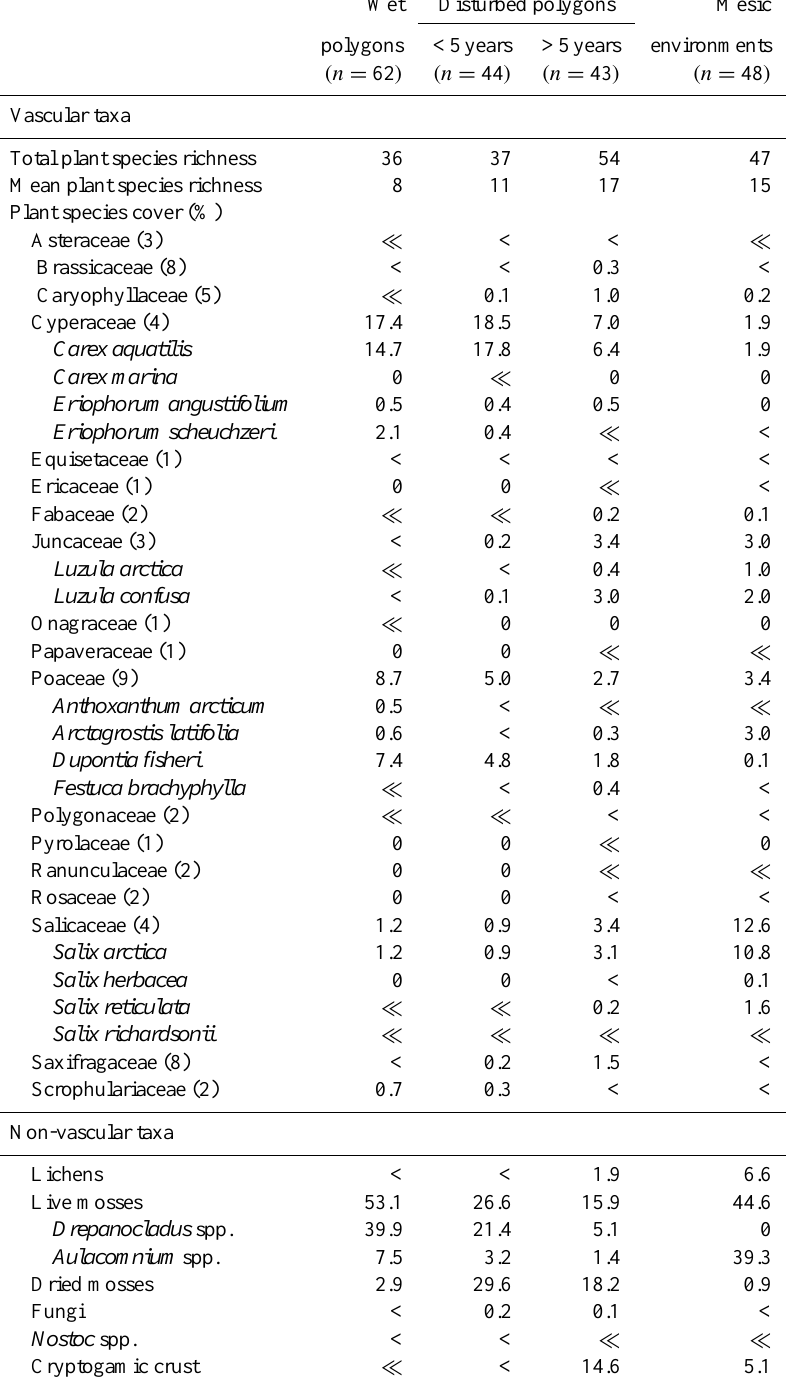
Table 2. Species richness, family total cover and species mean cover of vascular taxa as well as mean cover of non-vascular taxa in each of the four habitat types studied in the Qarlikturvik valley, Bylot Island, Nunavut. Mean species richness is given for sampled areas of 49dm 2 (70 × 70cm quadrats). Numbers in brackets denote the number of species inventoried in each family. (cid:28)= cover <0.01%; < = cover < 0.1%. Species names were retrieved (2011) from the Integrated Taxonomic Information System (ITIS)